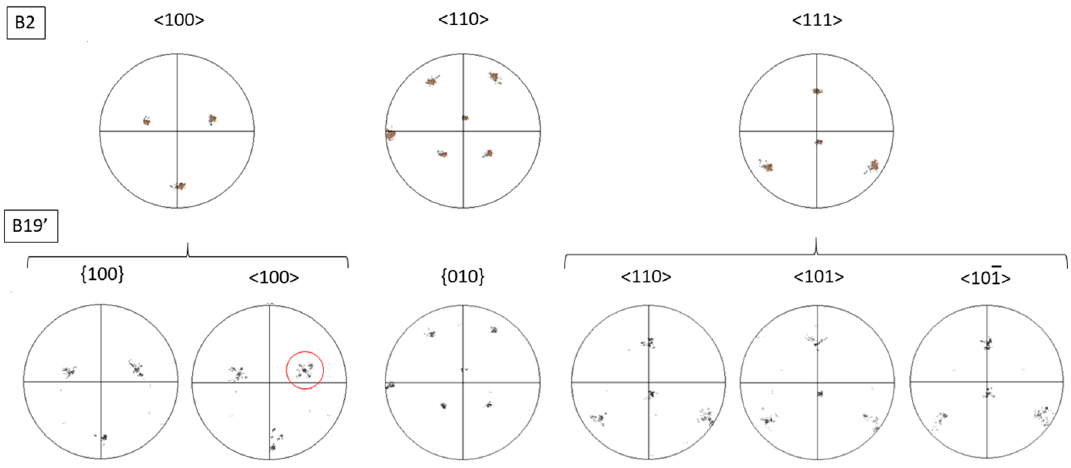
Figure 6. Convention used to plot the monoclinic B19 ′ rotation axes on a stereographic projection (upper sphere). Any point P is projected on a point p on the disk (XY). We use the conventions b B19 ′ // Y and c B19 ′ // Z . Since the direction a B19 ′ intercepts only the lower sphere in A, its opposite in A’ must be used and its projection is noted - a .